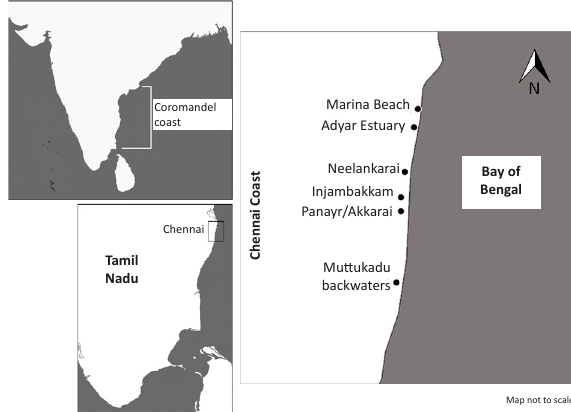
Image 1. Map of the study